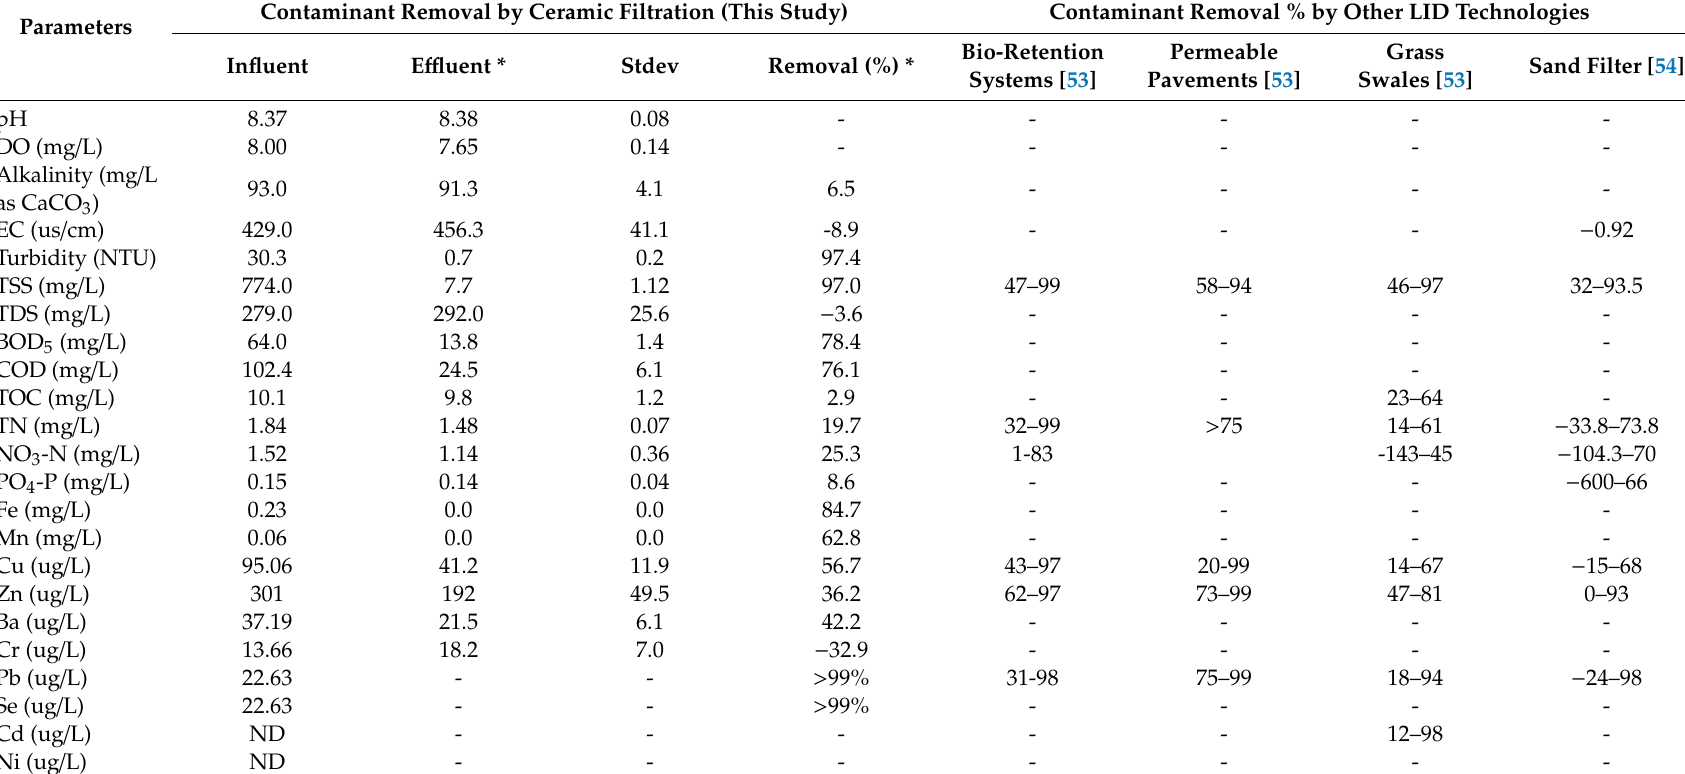
Table 3. E ffl uent water quality of ceramic filtration of this study and others LID